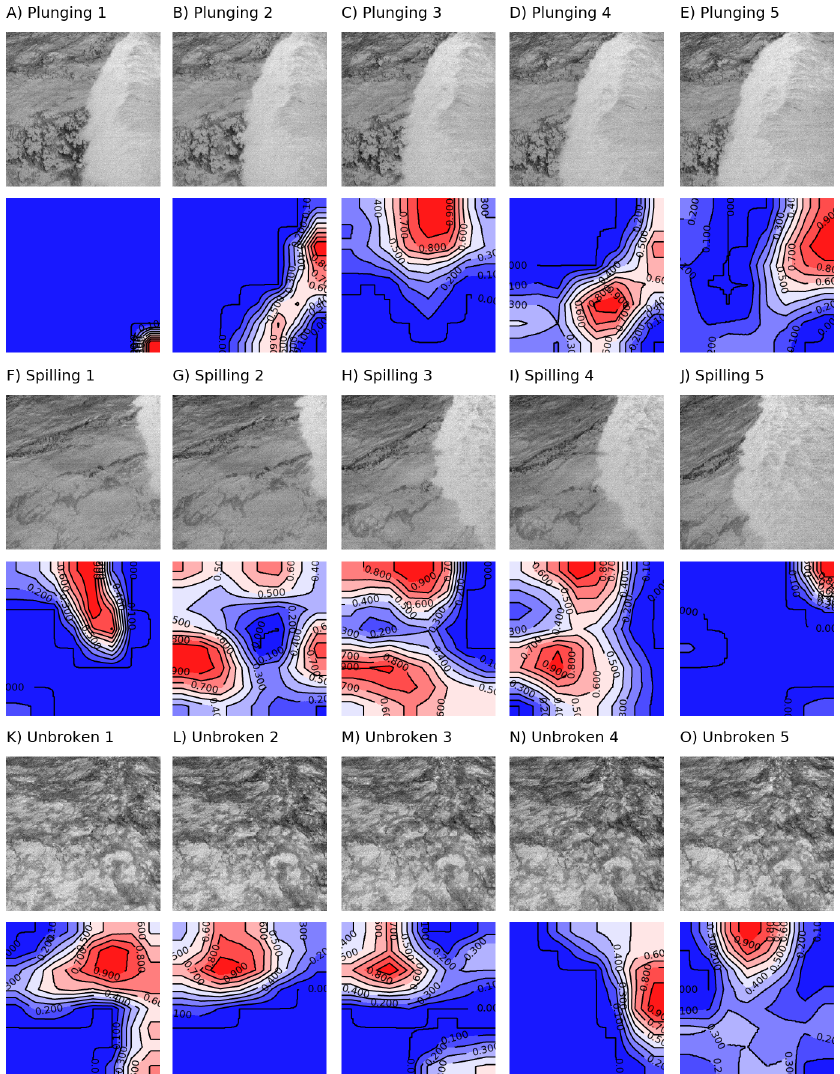
Figure 5. Class activation maps of five sequential example images for each of three wave breaker classes: ( A – E ) plunging; ( F – J ) spilling, and ( K – O ) unbroken. Relatively high values (red colors) are regions of relative importance with respect to the class